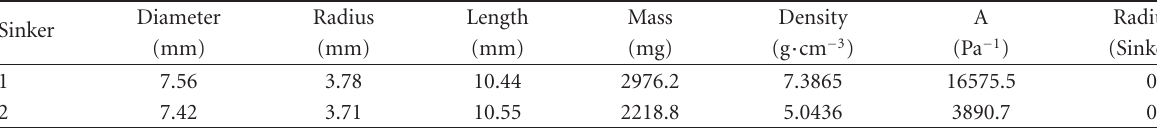
Table 2: Sinker details.